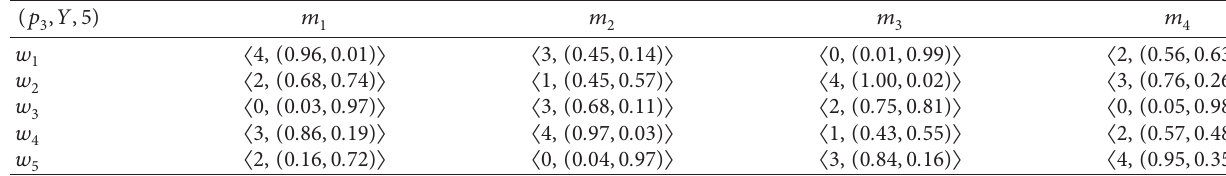
Table 4: Tabular representation of